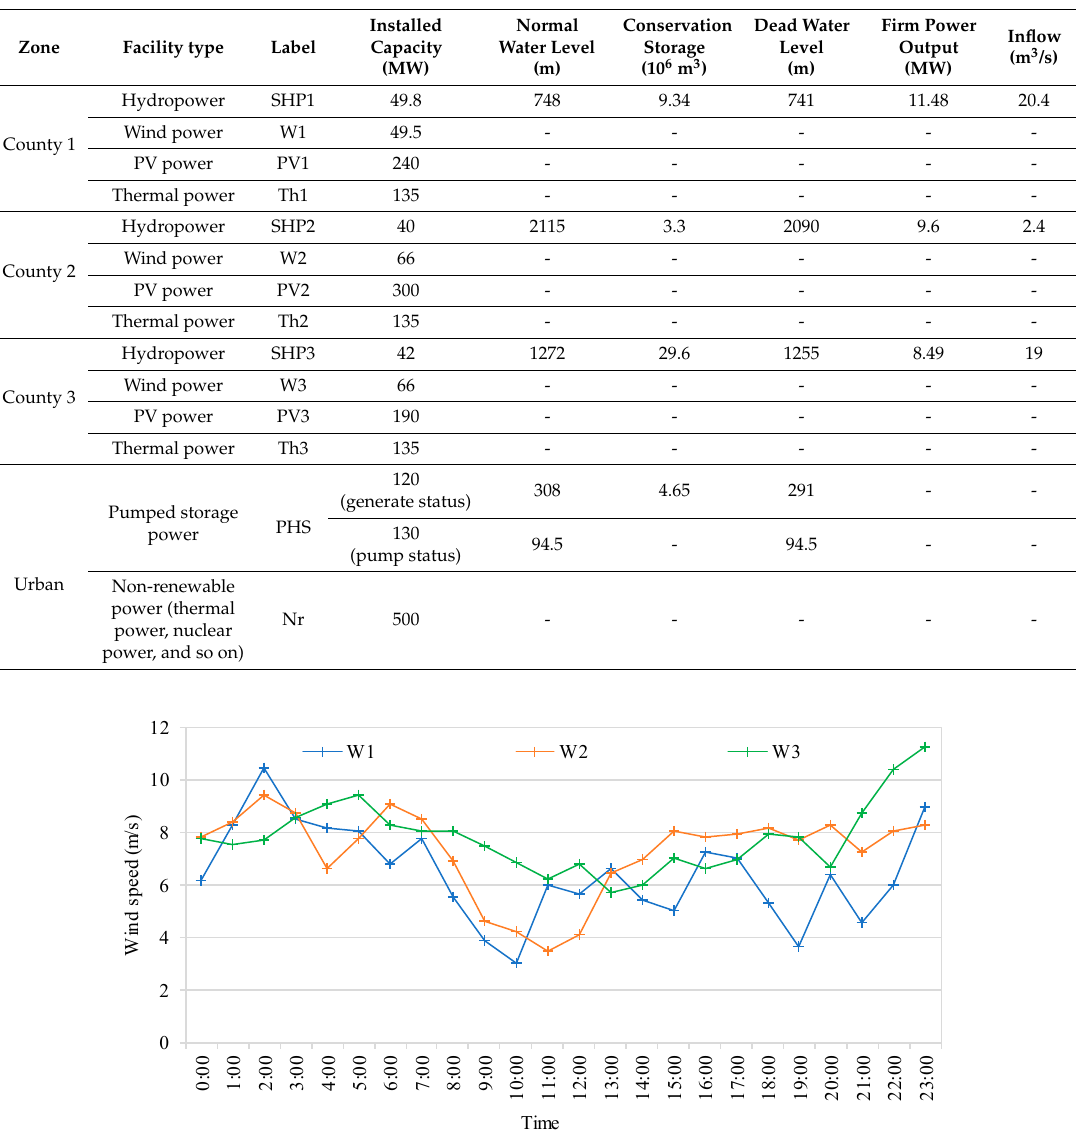
Figure A2. Solar radiation of the PV power station (source: POWERCHINA Kunming Engineering Corporation Ltd.).